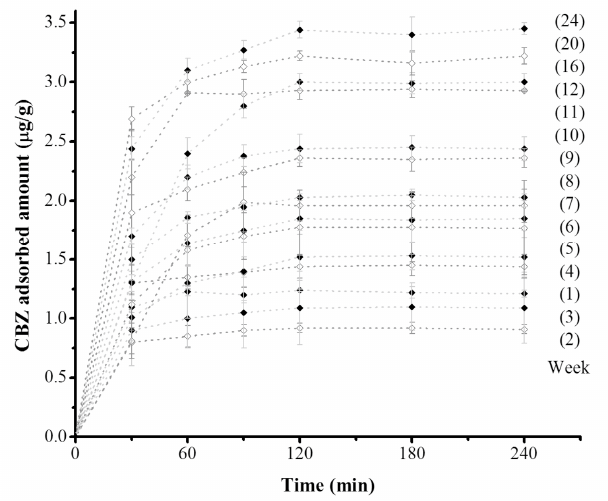
Figure 5. Adsorption kinetics of CBZ onto tezontle with different periods of biofilm formation. Error bars represent standard error of triplicates.